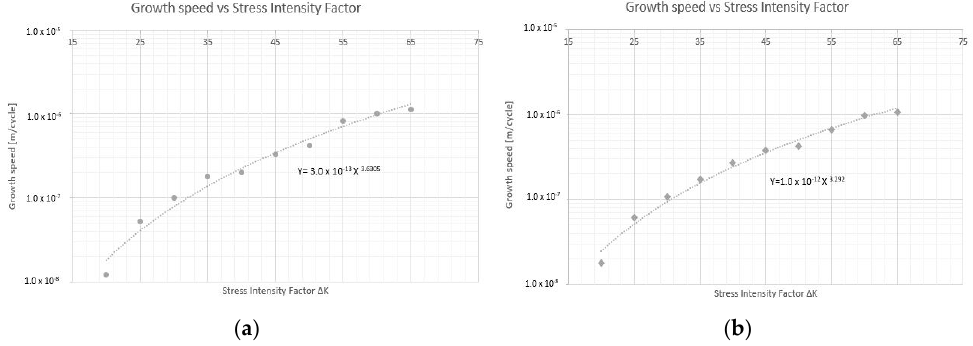
Figure 11. Growth speed vs. intensity factor. ( a ) Corbones Stringers, m = 3.63; C = 3 × 10 − 13 ; ( b ) Corbones Main Chords, m = 3.29; C = 1 × 10 − 12 .